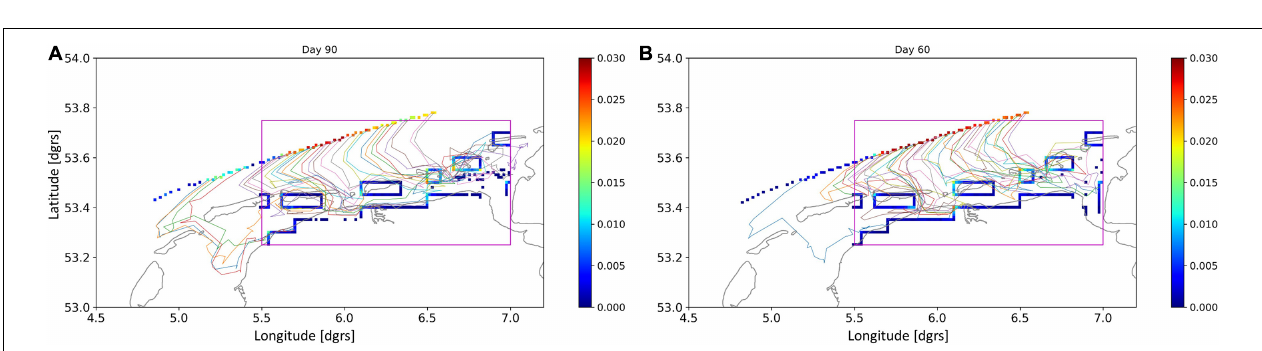
FIGURE 6 | Time series of the simulated aftermath of the MSC Zoe incident. (A) Wind speed and direction to the north of Ameland (53.5N, 5.75E) at 6 h intervals from the ECMWF ERA5 reanalysis; (B) number of live particles representing HDPE pellets released along the trajectory of MSC Zoe; (C) number of live particles representing PS grains released along the trajectory of MSC Zoe. Legend: combination of diffusion coefficient and vertical particle velocity.